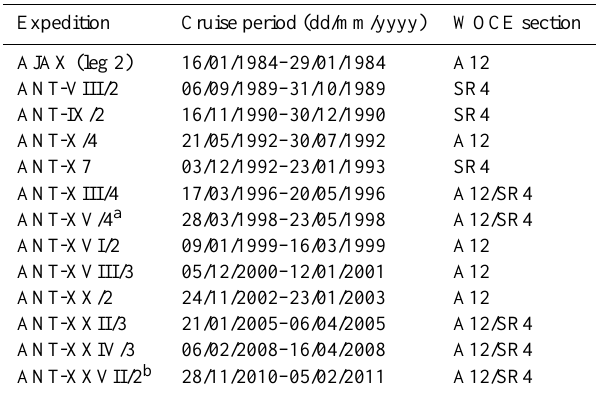
Table 2. Overview of the observed hydrographic sections used for the validation of the reanalyses. Details of the observed data can be found in Whitworth and Nowlin (1987), Fahrbach et al. (2001, 2004, 2007, 2011), Fahrbach and De Baar (2010) and Rohardt et al.